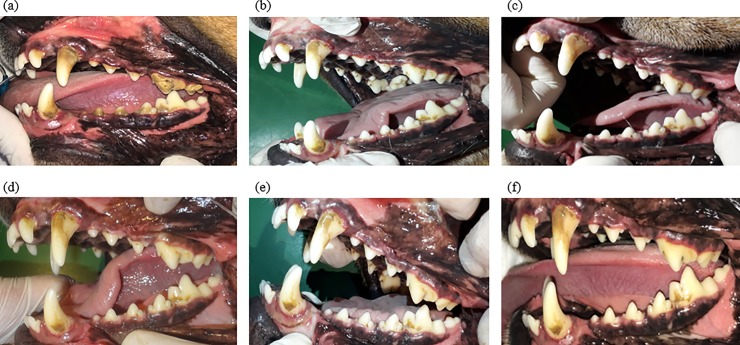
Left dental arcade of the same dog at days 0, 3, 6, 9, 12, and 14 (a–f, respectively) after daily supplementation of autoclaved compact bone.